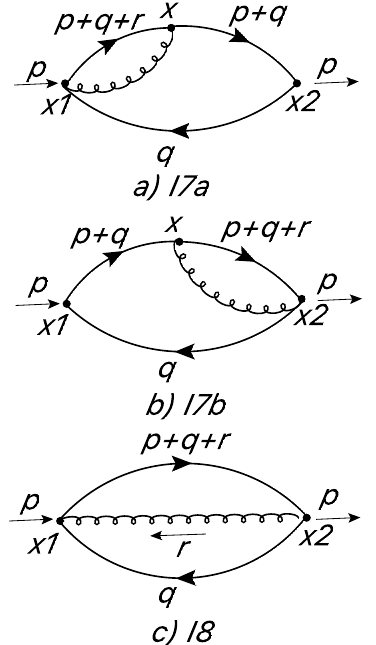
JHEP12(2020)026